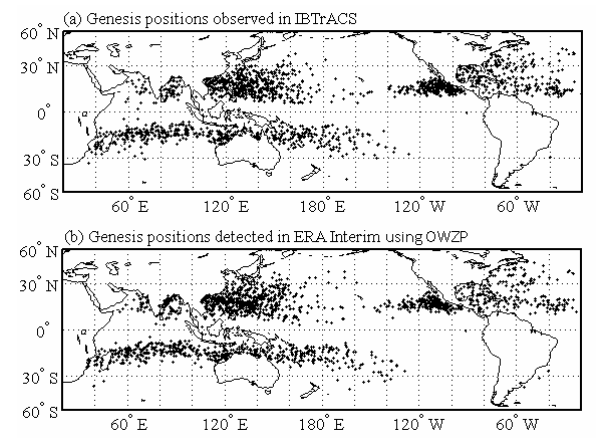
F IG . 6. TC formation locations (a) observed in IBTrACS, and (b) detected in the ERA-interim reanalysis data using OWZP5 (Table 1) for the period 1989-2008.